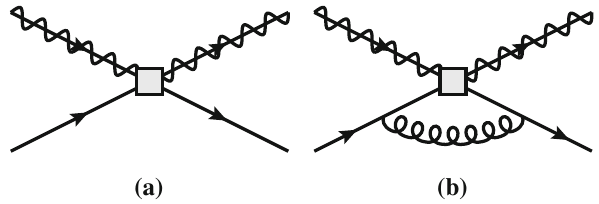
Fig. 2 Tree-level ( a ) and one-loop ( b ) Feynman diagrams for DM- quark scattering in the effective theory, where the four-fermion interac- tion is indicated by a grey square